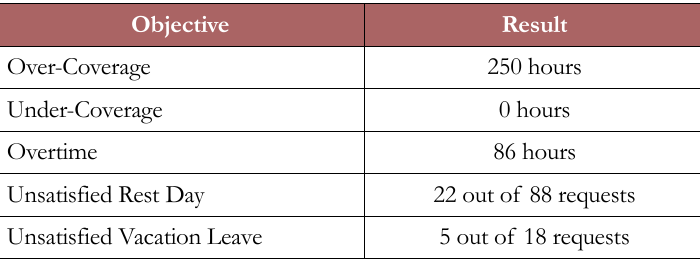
Table 10. Summary of results from Proposed